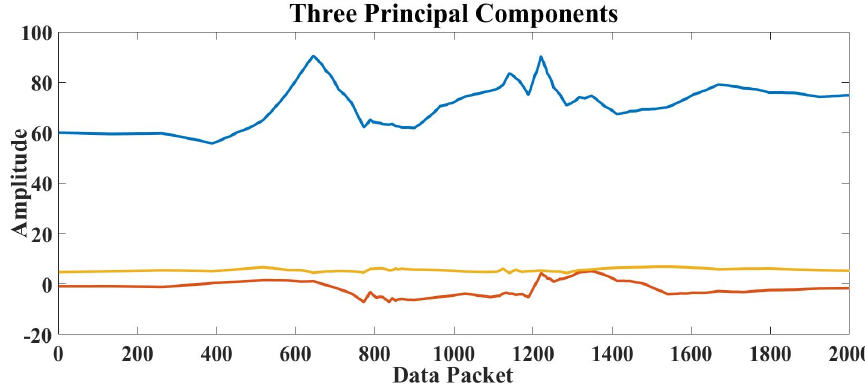
Figure 7. PCA processing results.